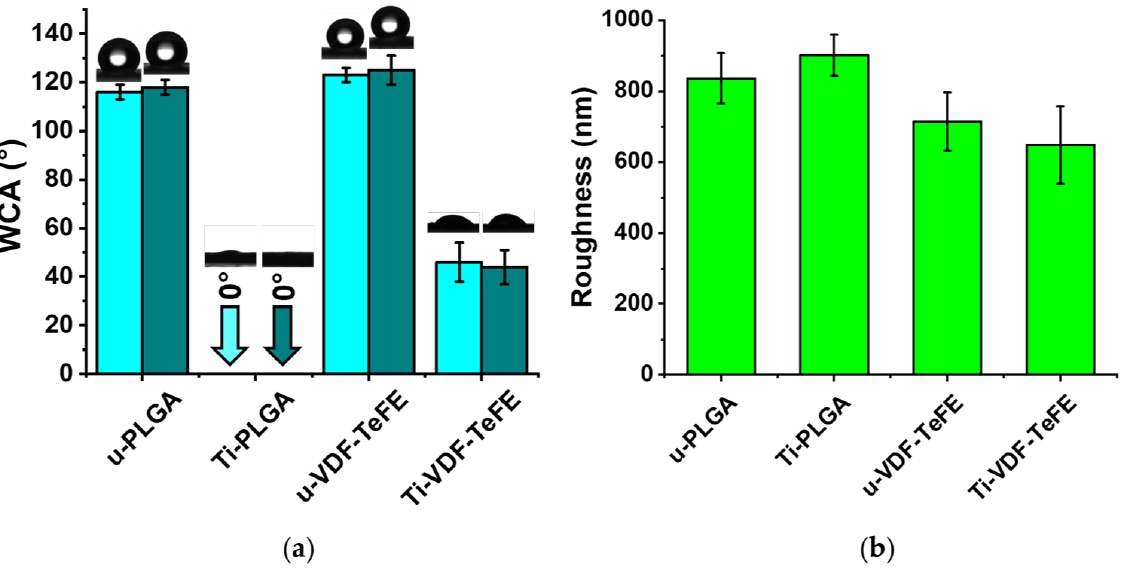
Figure 4. Water contact angles (WCA) and roughness of u-PLGA, Ti-PLGA, u-VDF-TeFE and Ti-VDF-TeFE scaffolds: ( a ) WCA values after 2 s of liquid contact with the scaffold ’ s surface (marked in cyan) and after 1 min (marked in dark cyan); ( b ) roughness values (marked in light green). The WCA of Ti-PLGA scaffolds is shown as 0°. All values are shown as mean ± SD. A higher wettability of polymer scaffolds surface-modified with titanium is related to the amount of titanium oxide compounds on the polymer fibers. TiO 2 can lead to the formation of hydroxyl groups ( – OH), which contribute to the formation of hydrogen bonds between TiO 2 on a metal film and water [64]. It is known that titanium oxide-con- taining thin films prepared by DC magnetron sputtering have hydrophilic properties [65]. Atomic force microscopy micrographs show that the surfaces of unmodified and sur- face-modified PLGA and VDF-TeFE scaffolds exhibited a non-woven structure (SI Figure S6), which correlates with the results of scanning electron microscopy (Figure 2). Unmod-